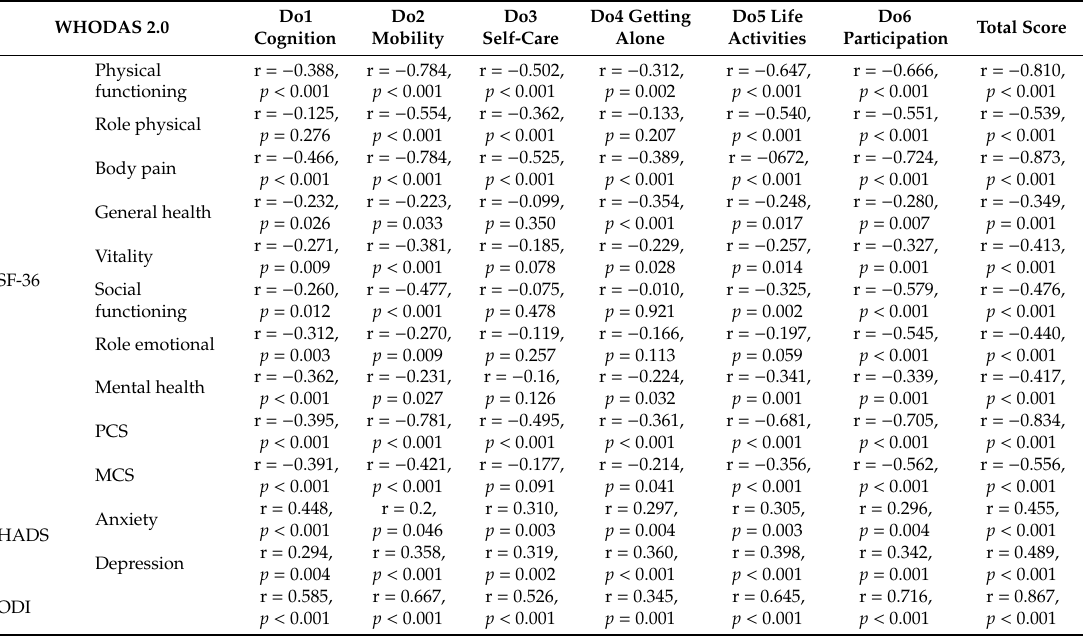
Table 4. Convergent validity of the 36-item WHODAS 2.0 for patients with